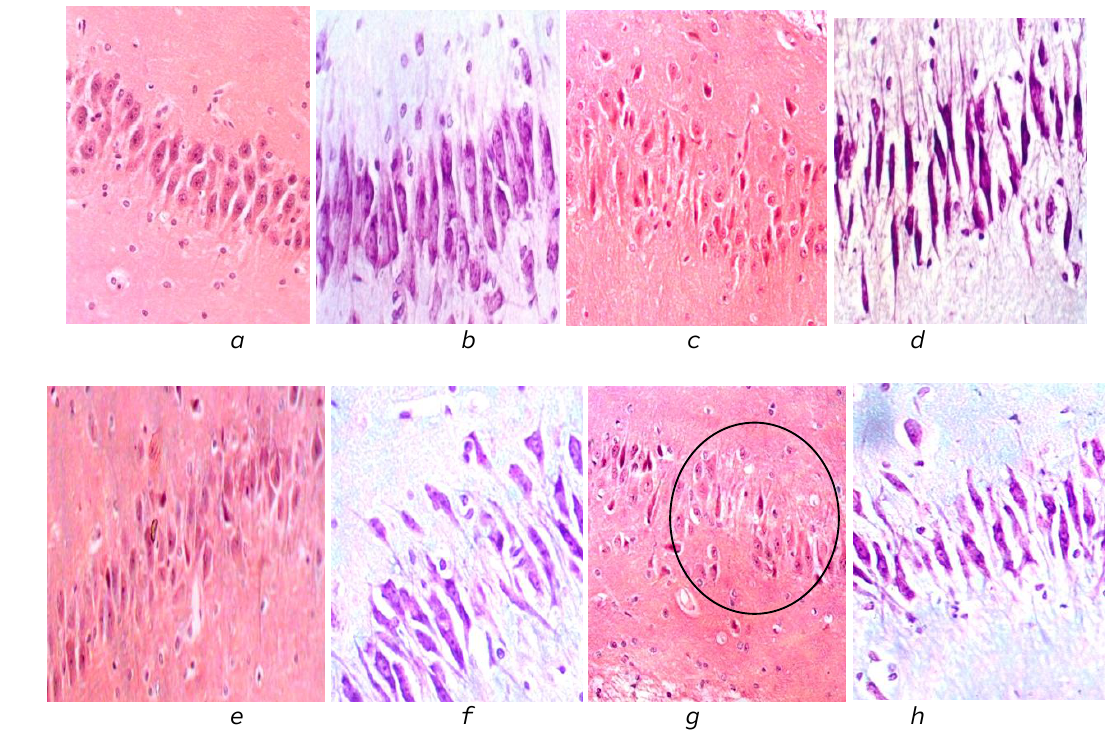
Fig. 2. Zone CA of the ventral hippocampus: a, b : pseudo-operated animals ( a – rows of large polygonal neurons 3 (hematoxylin-eosin. 250); b - the state of the tigroid substance in the neuroplasm of the vast majority of neurons corresponds to normal (thionin by the method of Nissl. ×250); c, d – rats with ACVA on the 6th day after modelling (c – disorganization, decrease in neuronal density, “loss” of cells from rows, pericellular edema, change in shape and size of neurons; d – predominance of hypochromic neurons (thionine by the method of Nissl. ×250; e, f – rats with ACVA, which were treated with the compound KGM-5 (30 mg/kg); ( e – restoration of the architecture of the series, the density of neurons in the series) (hematoxylin-eosin. ×250); g, h – rats with ACVA, which were treated CD “Picamilon” (17 mg/kg): g – violation of the cytoarchitectonics of the layer, the loss of neurons from the series (hematoxylin-eosin. ×250); h – almost unaltered area with normochromic and hypochromic neurons (thionin by the method of Nissl.